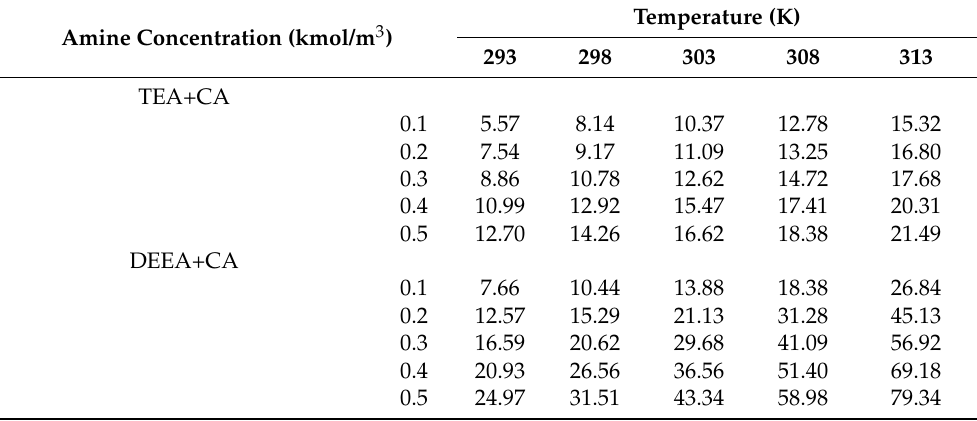
Table A4. Experimental kinetics data of k 0, with CA of CO solutions containing 3 g/m 3 CA over a temperature range of 293–313